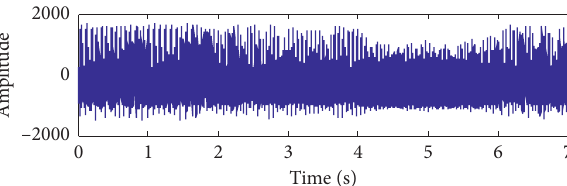
Figure 13: The time-domain waveform of vibration